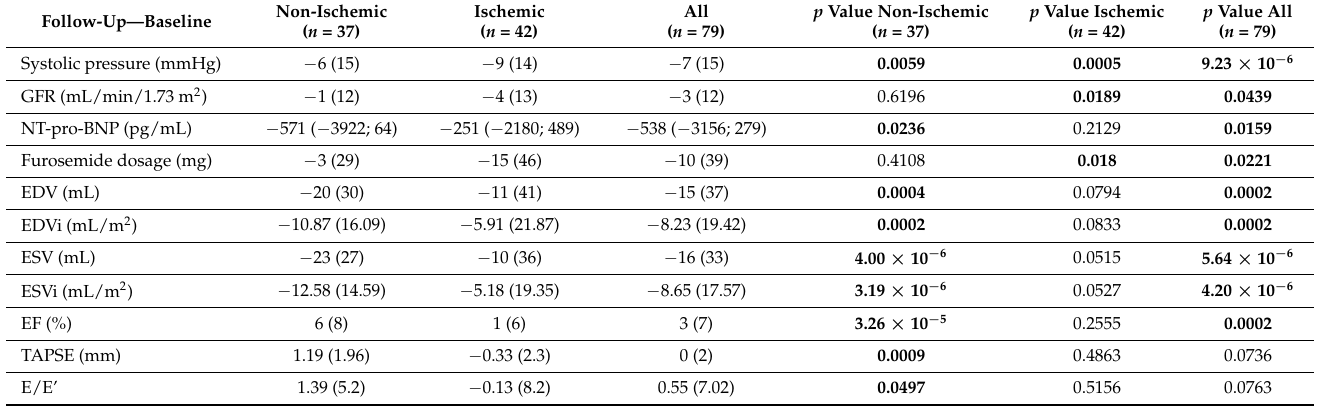
Table 2. Differences in clinical and echocardiographic parameters between follow up and baseline. Means of differences and standard deviations in brackets; the variable “delta NT-proBNP” is character- ized by some extreme outliers and therefore it is shown as medians of the differences and interquartile range in brackets. GFR = Glomerular filtration rate, NT-proBNP = N-terminal pro-B-type natriuretic peptide, EDV = end diastolic volume, ESV = end systolic volume, EF = ejection fraction, TAPSE = tricuspid annular plane systolic excursion. Bold values are statistically